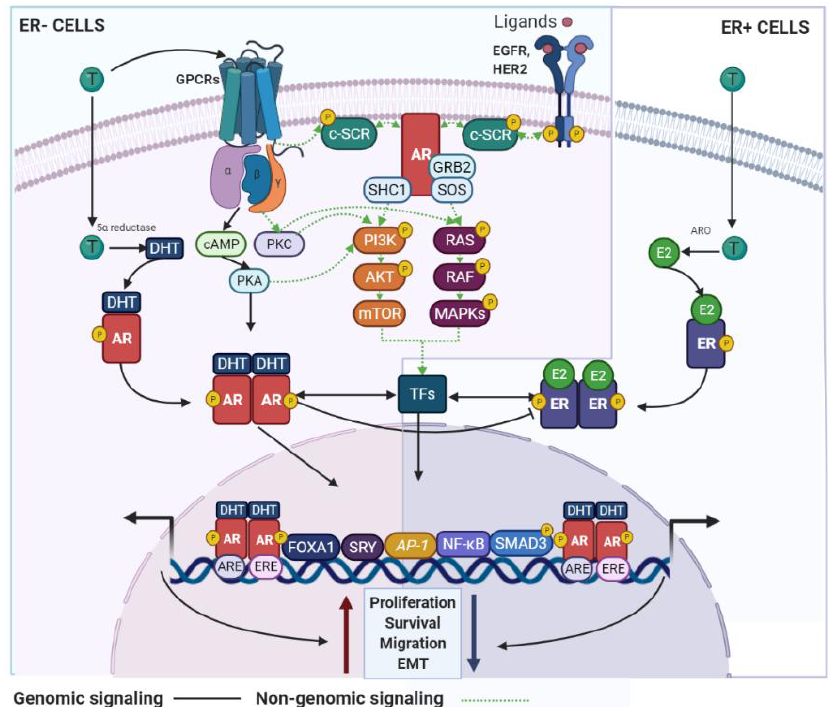
Figure 4. AR signaling in BC cells. AR use genomic and non-genomic mechanisms that can regulate BC development. These signaling pathways are associated with inhibitory or stimulatory effects on the BC cell growth and are dependent of the ER status. GPCR—G protein-coupled receptors; SHC1—SHC adaptor protein 1; SOS—SOS Ras/Rac guanine nucleotide exchange factor; ARO—aromatase.